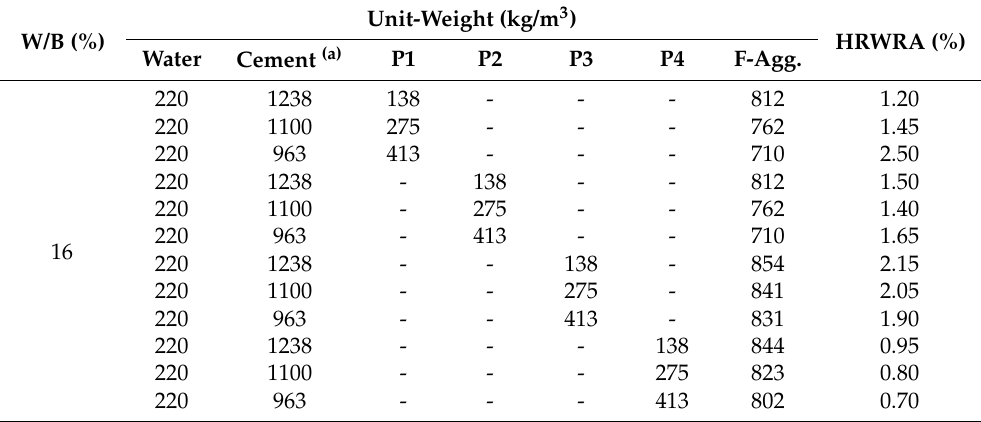
Table 5. Mixture proportions of base mortar (a test for cement replacement by powder